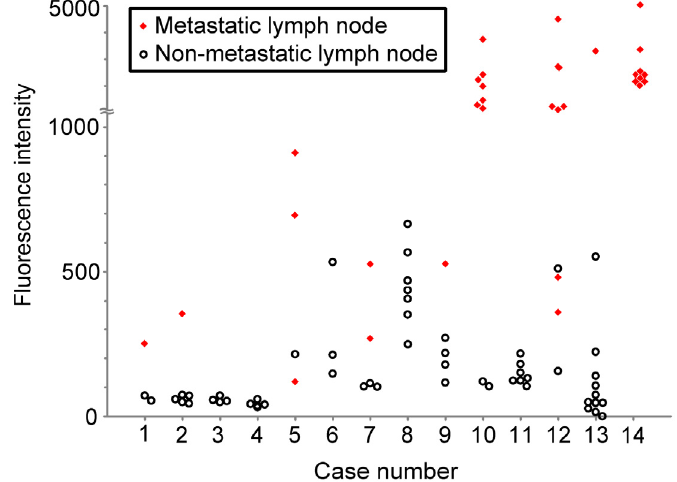
Figure 3. Scatter-plot for PpIX fluorescence intensities of metastatic and non-metastatic LNs. The signal intensities for the unmixed images of PpIX of LNs are plotted along the ordinate in each case. Closed diamonds denote metastatic LNs, opened circles denote non-metastatic